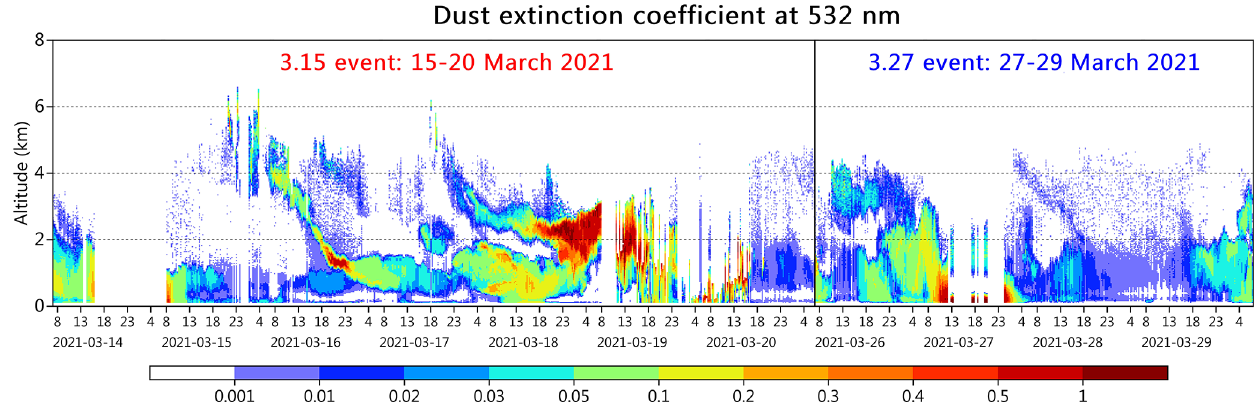
Figure 7. Time–height evolution of dust extinction coefficient (km − 1 ) at 532nm retrieved by ground-based lidar (location of the site shown in Fig. 1) during the 3.15 and 3.27